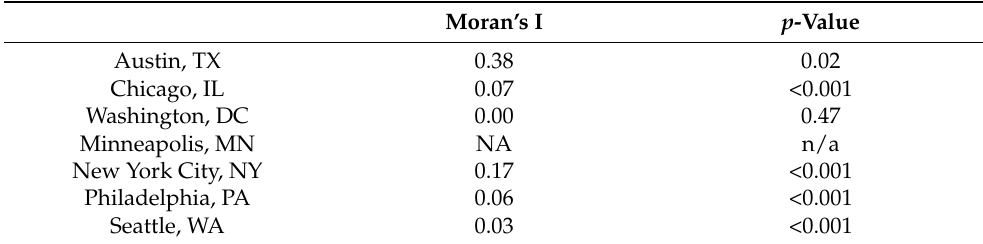
Table 3. Moran’s I for different